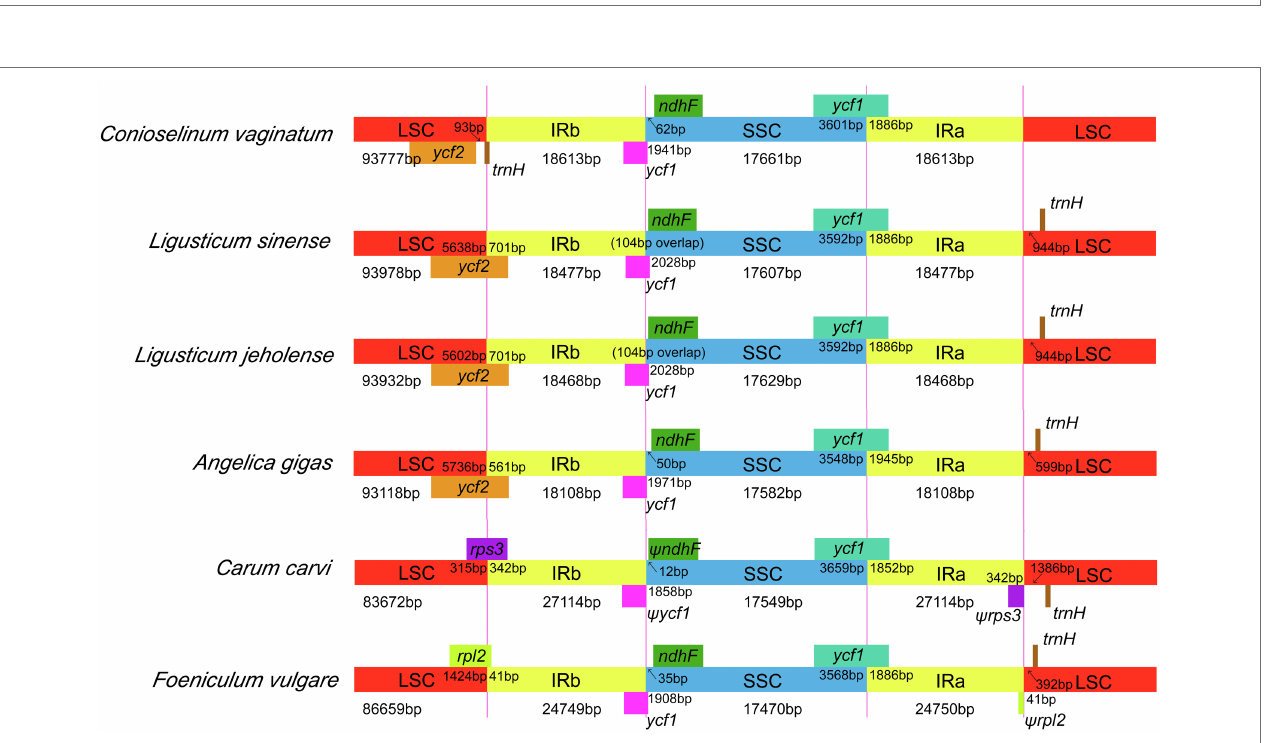
FIGURE 4 | Repeat sequences in three chloroplast genomes. F, P, R, and C indicate the repeat types F (forward), P (palindrome), R (reverse), and C (complement), respectively. Repeats with different lengths are indicated in different colors.